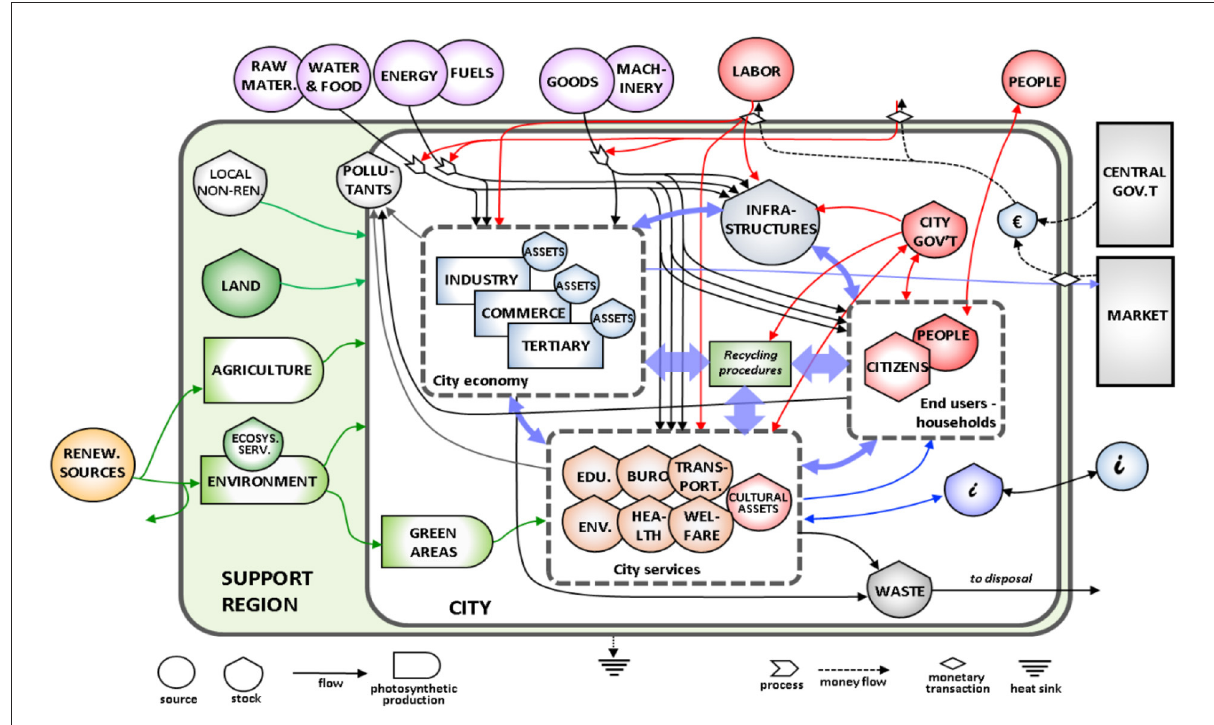
FIGURE1 Stock-flow diagram of a city and its support region (adapted from Gonella, 2019; Cristiano et al.,